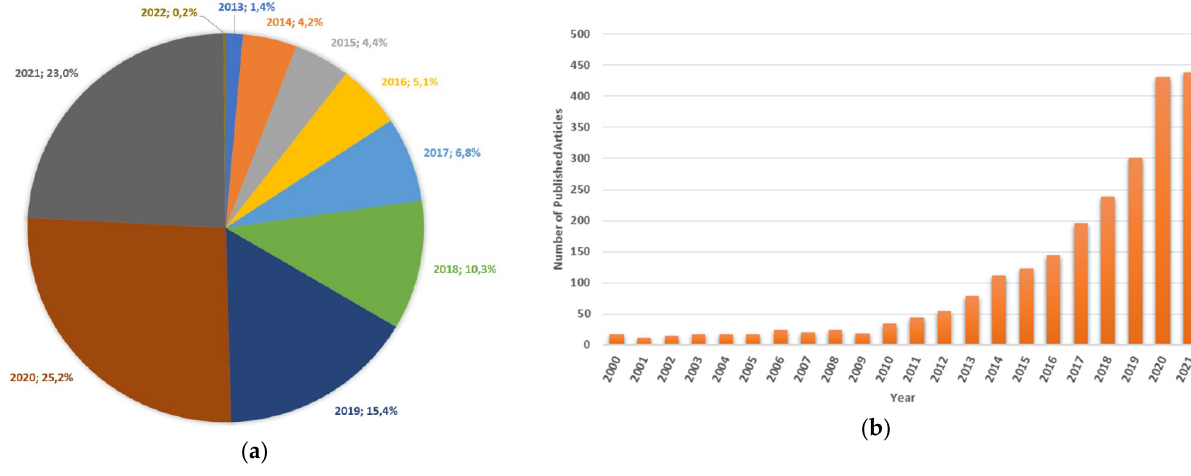
Figure 8. Yearly publications on LIB recycling: ( a ) graphical and ( b ) table